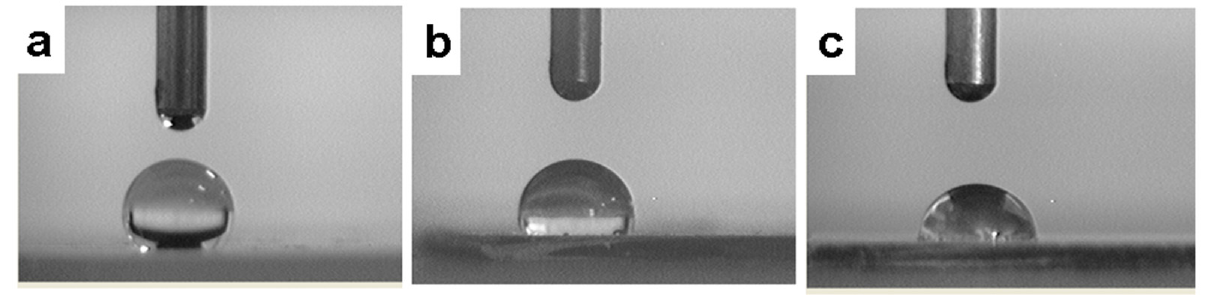
Figure 9. Shape of a water droplet on a silicon wafer dip-coated with polyphosphazene micro-nanospheres: ( a ) 6FPZF, ( b ) 3FPZF, ( c ) TPZF.